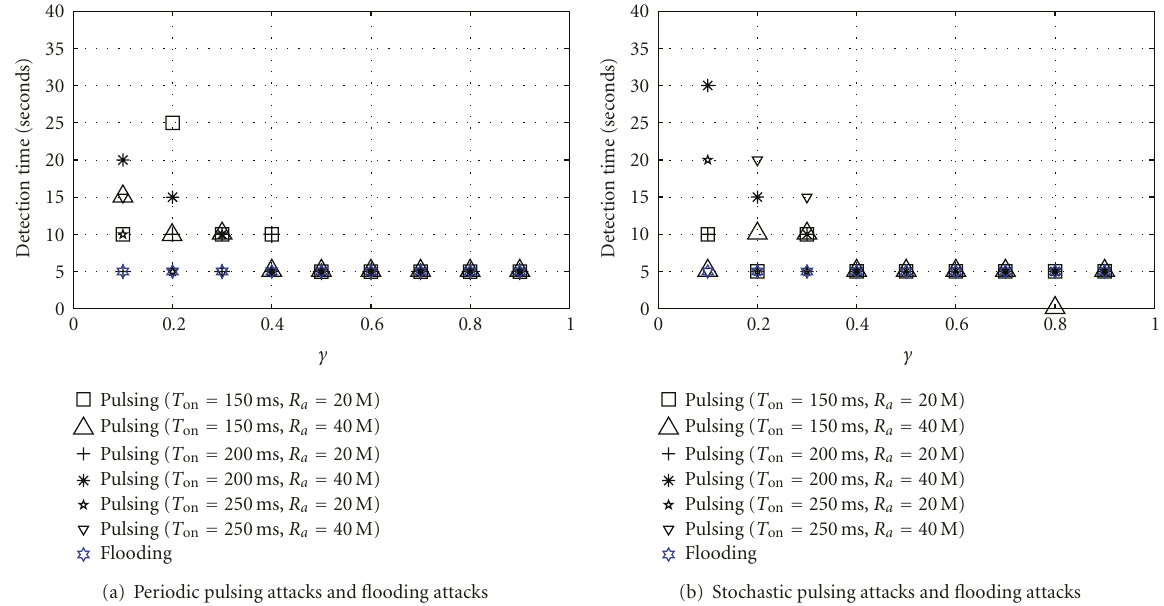
Figure 7: Average detection time for pulsing and flooding attacks using